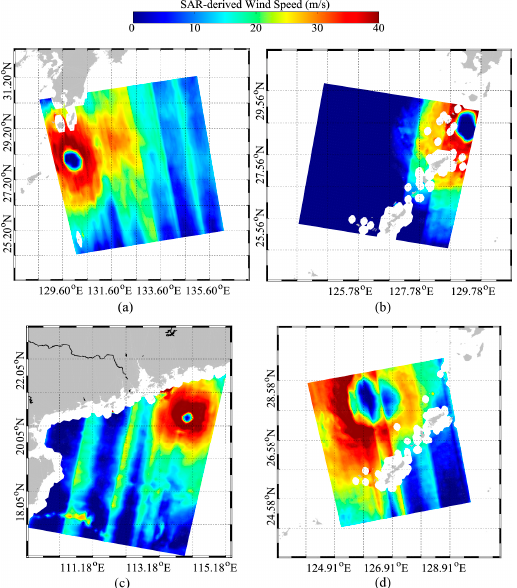
Figure 8. The retrieved wind maps of the four S-1 images. ( a ) Lionrock acquired on 29 August at 08:32 UTC. ( b ) Lester acquired on 31 August at 03:15 UTC. ( c ) Gaston acquired on 1 September at 20:30 UTC. ( d ) Lester acquired on 4 September at 16:31 UTC.